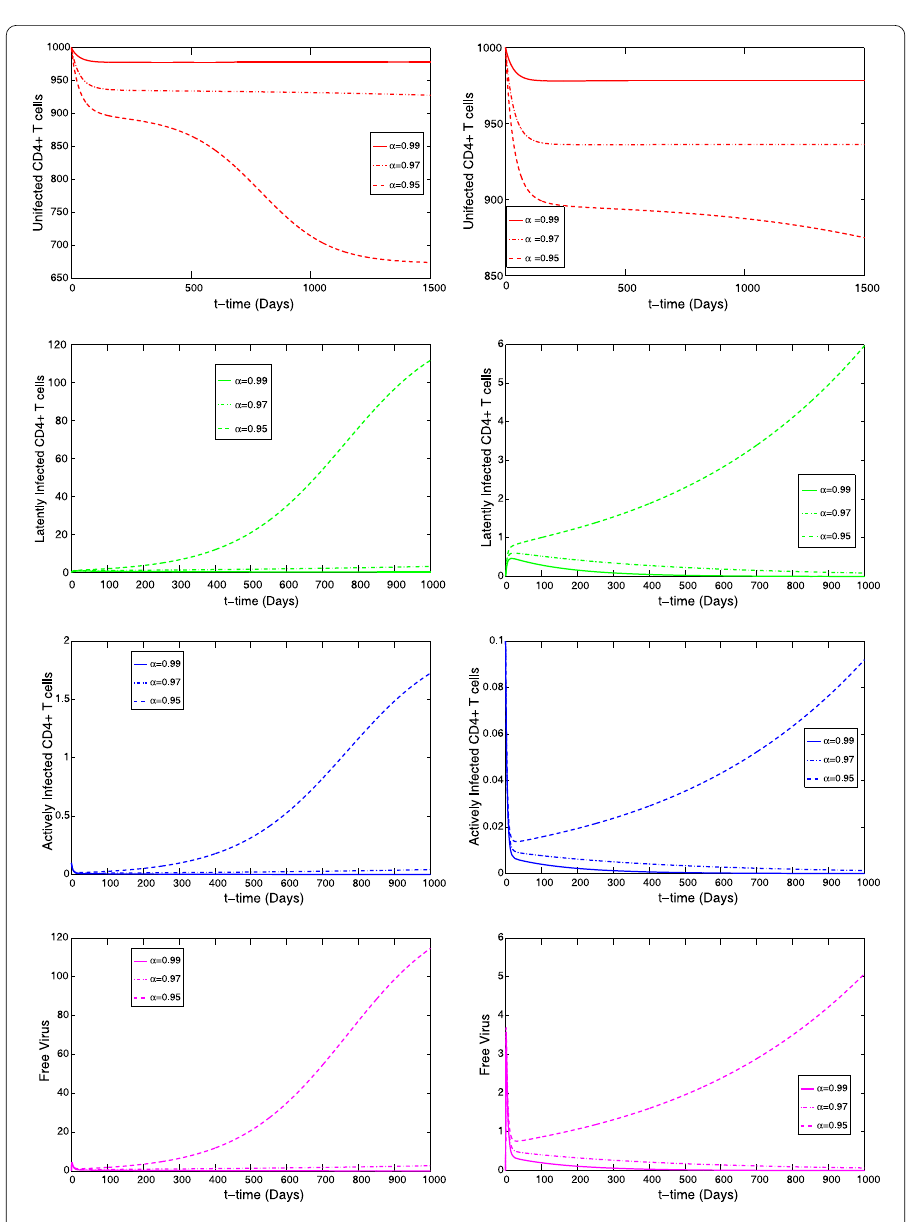
Figure 3 Solution of fractional HIV model with N = 600 (left panel) and N = 500 (right panel) for α = 0.99,0.97,0.95 with initial condition ( T 0 , T 0